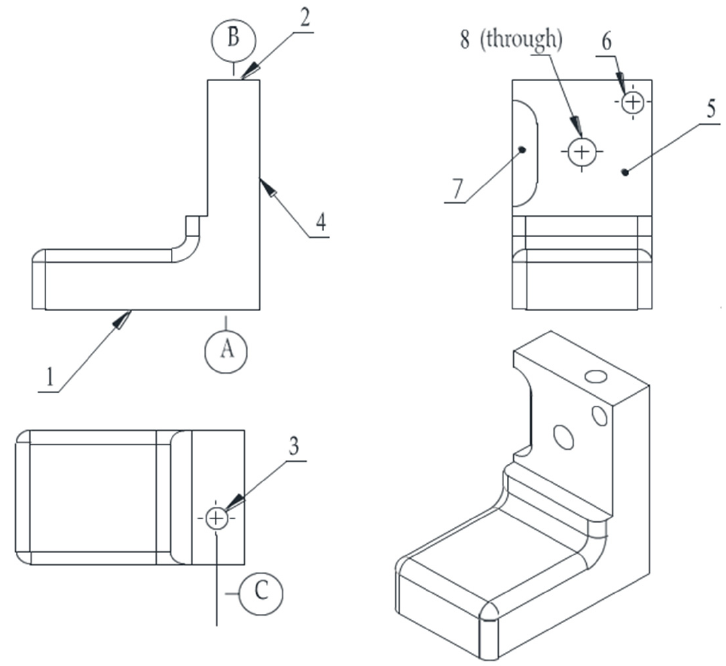
Figure 1. Simple bracket product processing case.